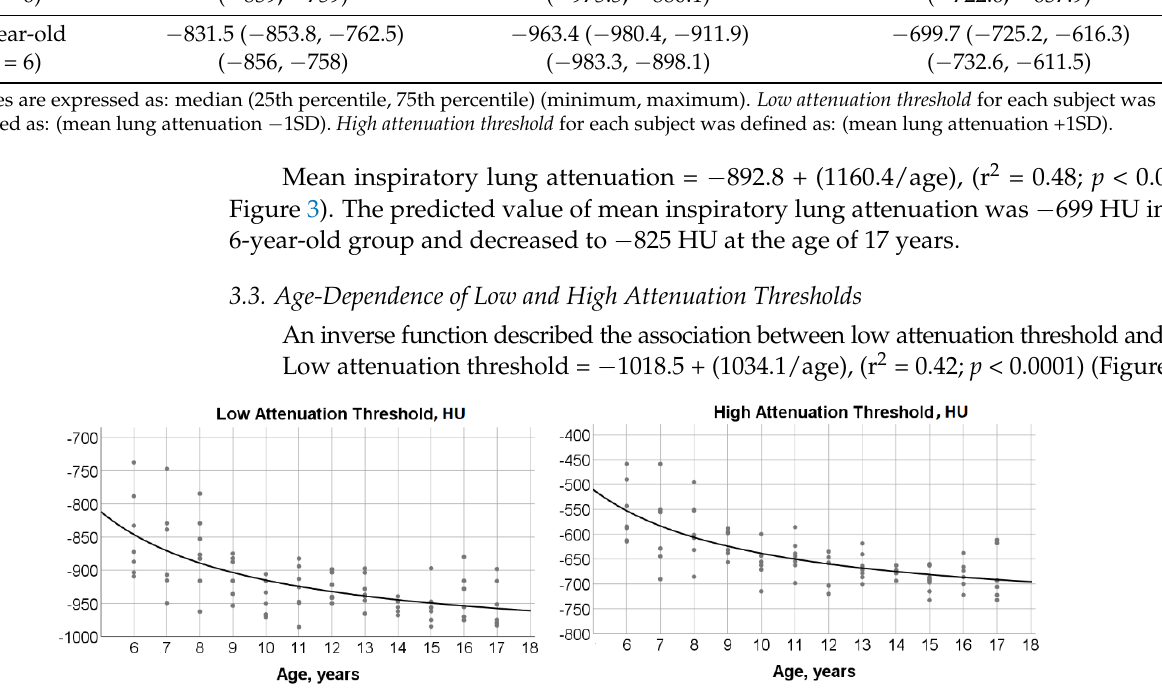
Figure 4. Left panel : Scatterplot and fit hyperbola curve describing the significant relationship between low attenuation threshold and age (r 2 = 0.42; p < 0.0001). Right panel : Scatterplot and fit hyperbola curve depicting the significant relation- ship between high attenuation threshold and age (r 2 = 0.50; p < 0.0001). Dots correspond to measured values for individual subjects.